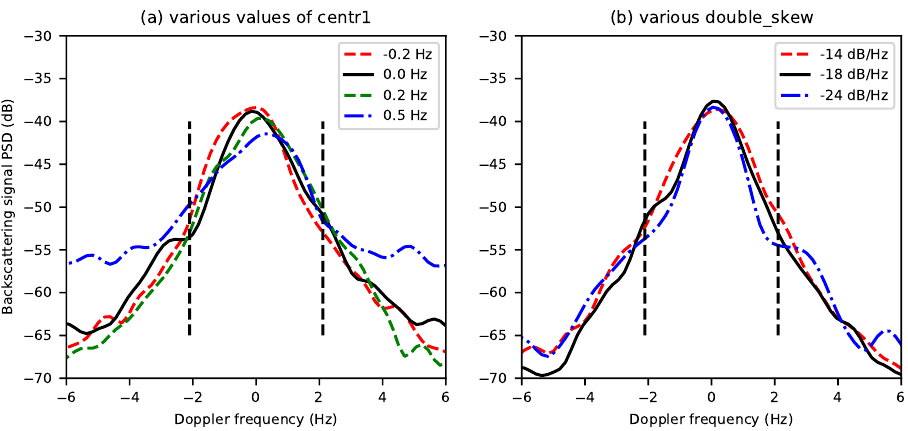
Figure 8. Examples of the backscattering spectra, obtained in the experiment (Pay attention to the feature values, printed in the legend). Vertical dash lines point the Bragg frequencies for a reference.